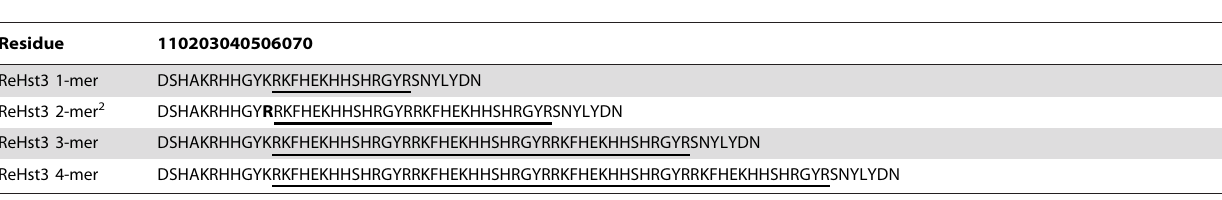
Table 2. Amino acid sequences of recombinant histatin 3 multimers 1 .